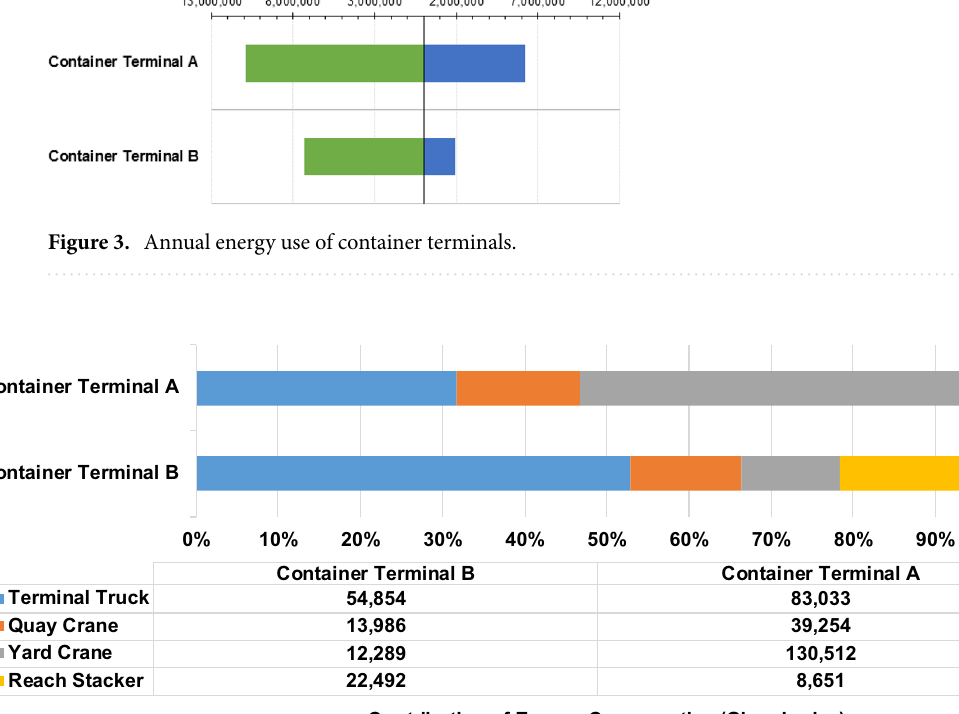
Figure 4. Contribution of container-handling equipment to the energy consumption at the container